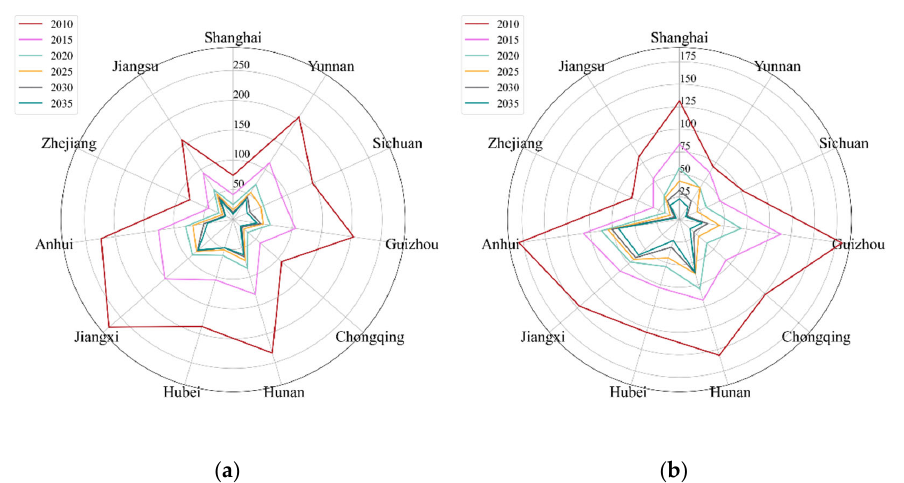
Figure 6. Water use indicators of 11 provincial administrative regions of the YREB . ( a )Water con ‐ sumption per 10,000 yuan of GDP (m 3 ). ( b )Water consumption per 10,000 yuan of industrial added value (m 3